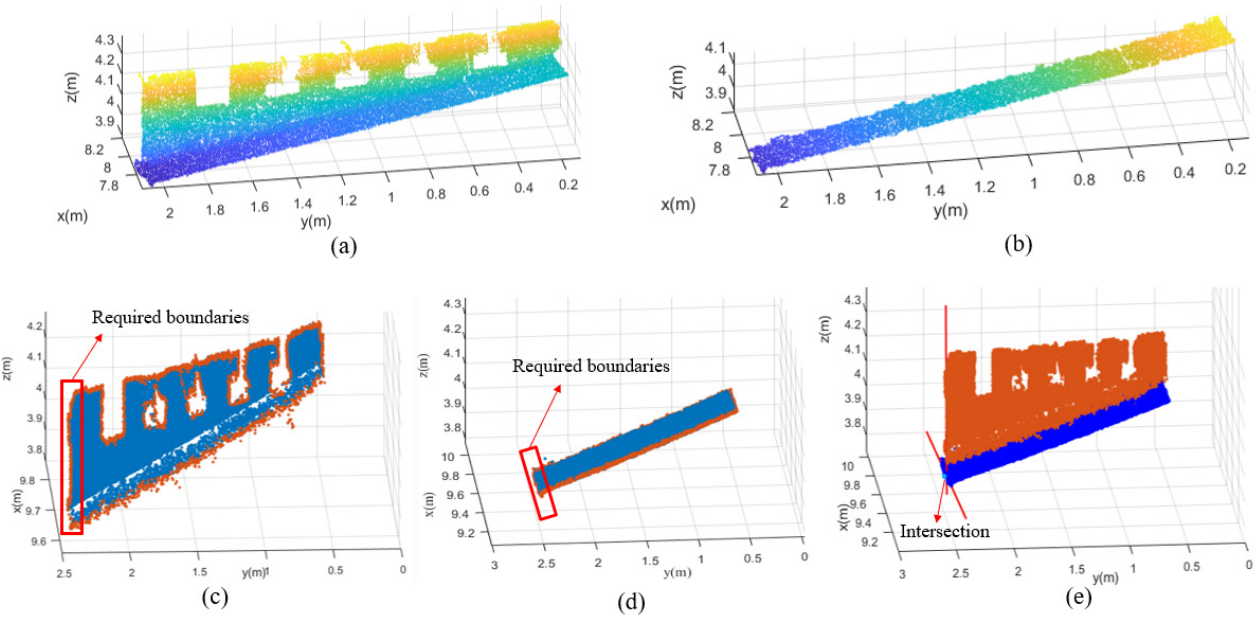
Figure 9. Calculation of the intersection point: ( a ) vertical plane of the T rib; ( b ) bottom surface of the T rib; ( c ) boundary of the vertical plane; ( d ) boundary of the bottom plane; and ( e ) the calculation of the intersection point of the target boundary line.